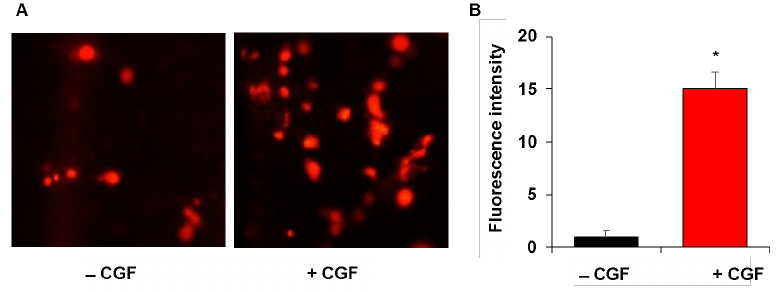
Figure 3. Endothelial cell adhesion on CGF-permeated implants. Implants without/with CGF ( − /+ CGF) were incubated in the presence of DilC18-labeled endothelial cells and their adhesion was monitored by a fluorescence microscope (×100 magnification) ( A ). The fluorescence intensity was quantified by ImageJ software and reported as arbitrary units ( B ). The results are expressed as the means ± SD of triplicate measurements from three independent experiments. (* p < 0.05 versus implants without CGF).